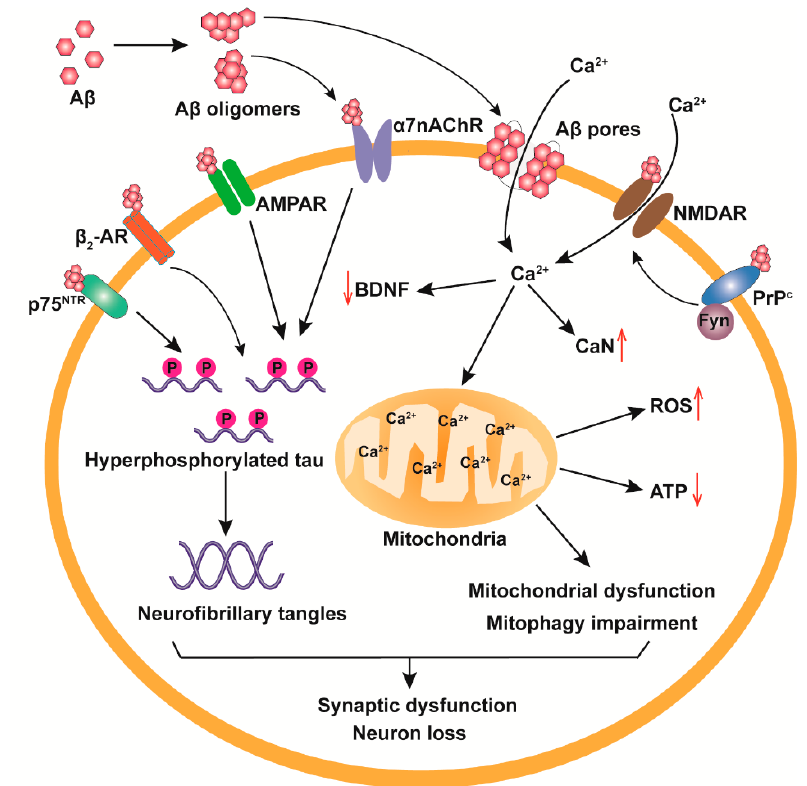
Figure 2. Schematic of the neurotoxicological mechanisms of A β os. A β os, mainly produced extracellularly, can bind to multiple receptors on the surface of neuronal membrane and interfere with the normal signaling pathways of the receptors, and they can also directly interact with membrane to form pore structure, leading to the change of membrane integrity and permeability. These two effects of A β os on cell membrane can further induce Ca 2+ homeostasis dysregulation, mitochondrial damage, reactive oxygen species (ROS) generation, reduction of ATP level and abnormal tau phosphorylation, resulting in synaptic dysfunction, neuron loss and impairment of long-term potentiation (LTP).